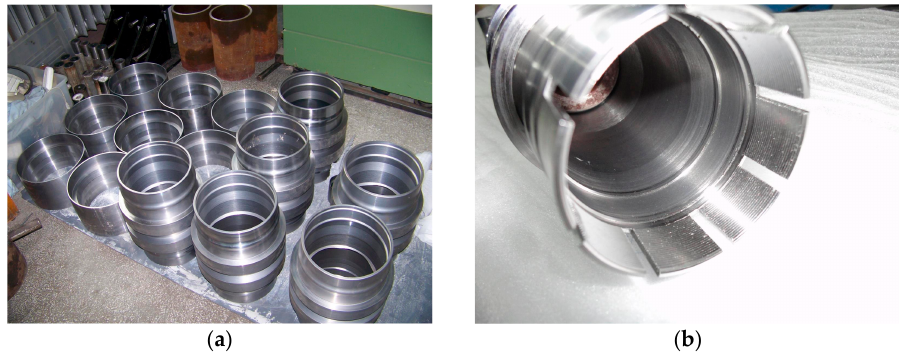
Figure 20. Prototypes: ( a ) DN 200 type and ( b ) DN 100 type.